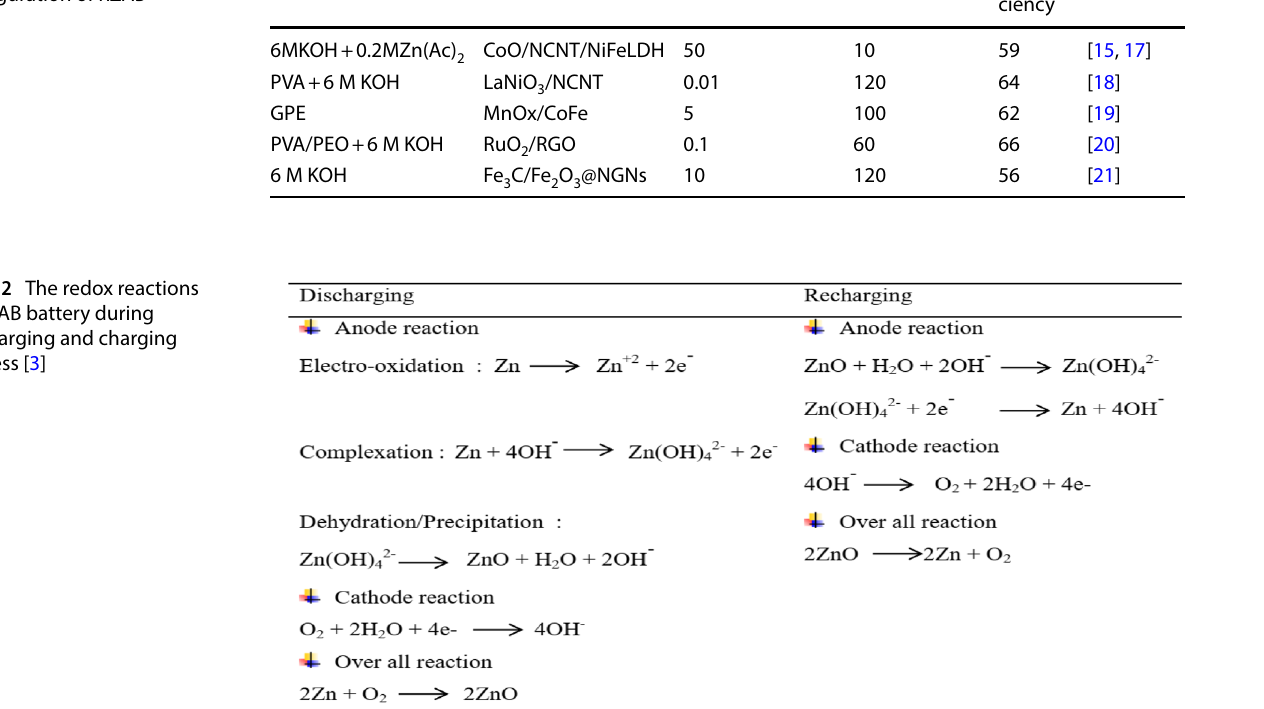
Table 1 Comparison of the performance of tri-electrode configuration of RZAB